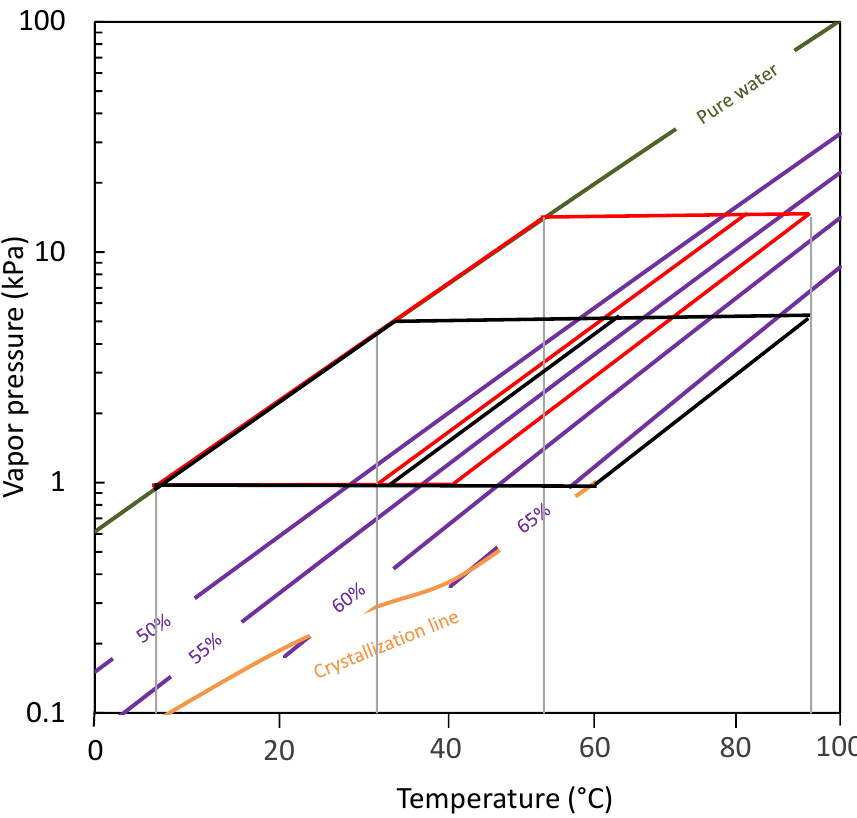
Figure 4. Dühring plot for the conventional single-effect H 2 O/LiBr absorption chiller and the proposed single-effect H 2 O/LiBr heat pump for combined heating and cooling.